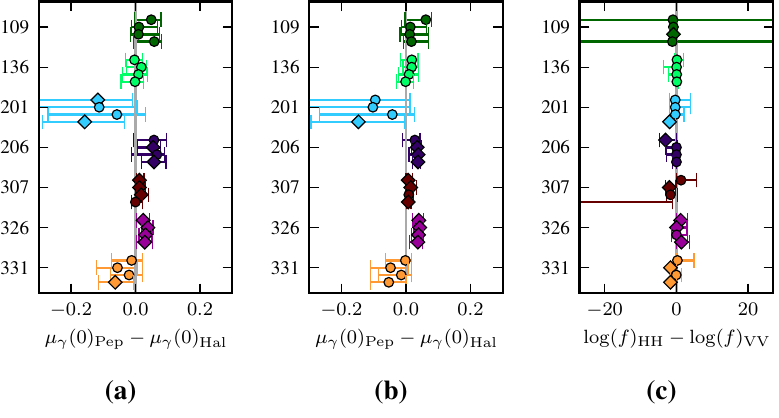
Figure 8. Bootstrap confidence intervals of differences in µ parameterizations. For each quantity and each ROI, the estimated difference is shown by the symbol (a diamond if it is significantly different from zero at α “ 0 . 05 , a circle otherwise), along with the 95% confidence intervals. ( a ) HH, A “ 0 , ζ “ 0 ; ( b ) VV, A “ 0 , ζ “ 0 ; ( c ) Hal, A “ 0 , ζ “ 0 .